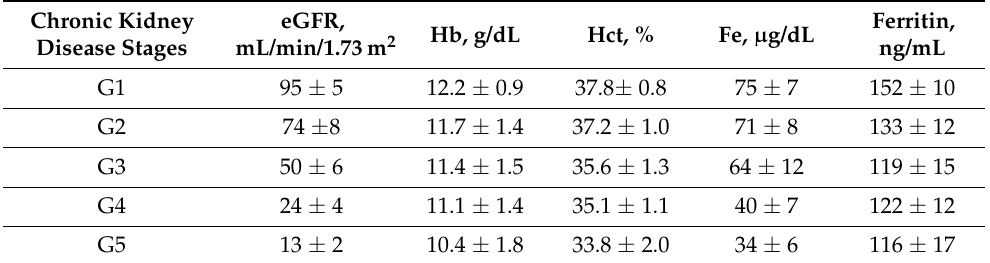
Table 2. Medium eGFR and biochemical parameters in the different CKD stages. Chronic Kidney Disease Stages